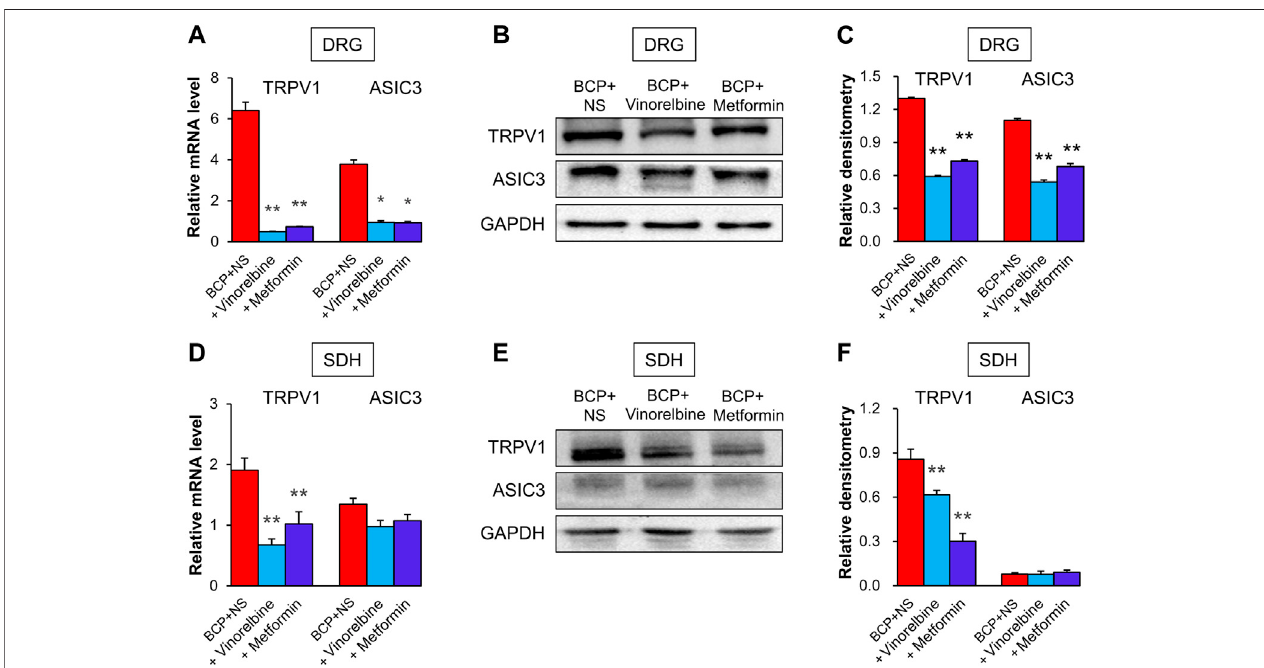
FIGURE 6 | Metformin and Vinorelbine decreased the expressions of TRPV1 and ASIC3. (A) Quanti fi cation of qPCR assays showed that the mRNA level of TRPV1 and ASIC3 were decreased in the ipsilateral DRGs of BCP rats treated with Vinorelbine or Metformin when compared with BCP + NS rats (* p < 0.5, ** p < 0.01 vs. BCP + NS, two-way repeated measures ANOVA followed by Tukey ’ s post hoc test). (B) Immunoblot showed the protein level of TRPV1 and ASIC3 in rat DRGs of BCP + NS, BCP + Vinorelbine, BCP + Metformin group. (C) The expression of TRPV1 and ASIC3 at the protein level in the ipsilateral DRGs of BCP rats treated with Vinorelbine or Metformin was greatly decreased when compared with BCP + NS rats(** p < 0.01 vs. BCP+ NS, two-way repeated measures ANOVA followed by Tukey ’ sposthoctest). (D) QPCRassaysshowedthatthemRNAlevelofTRPV1wasdecreasedintheipsilateralSDHofBCPratstreatedwithVinorelbineorMetformin when compared with a BCP + NS rats (** p < 0.01 vs. BCP + NS, two-way repeated measures ANOVA followed by Tukey ’ s post hoc test). While the mRNA level of ASIC3wasnotchanged ( p > 0.05vs. BCP+ NS,two-wayrepeated measures ANOVA followed by Tukey ’ spost hoctest). (E) Immunoblot showed theprotein levelof TRPV1 and ASIC3 in rat SDH of BCP + NS, BCP + Vinorelbine, BCP + Metformin group. (F) The expression of TRPV1 at the protein level was decreased in the ipsilateral SDH of BCP rats treated with Vinorelbine or Metformin when compared with BCP + NS rats (** p < 0.01 vs. BCP + NS, two-way repeated measures ANOVA followed by Tukey ’ s post hoc test). While the ASIC3 expression was not changed ( p > 0.05 vs. BCP + NS, two-way repeated measures ANOVA followed by Tukey ’ s post hoc